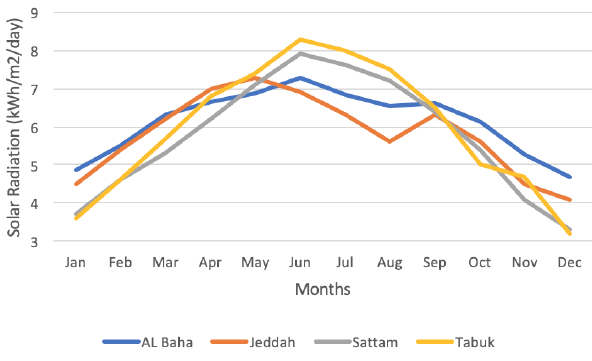
Figure 5: Monthly solar irradiation at the selected universities.